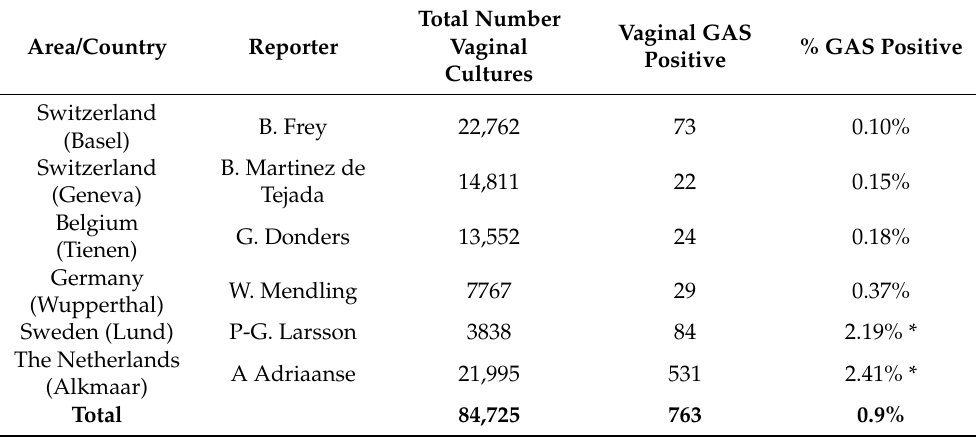
Table 3. Information on lab-based GAS prevalence in vaginal cultures from European countries provided by ISIDOG members.